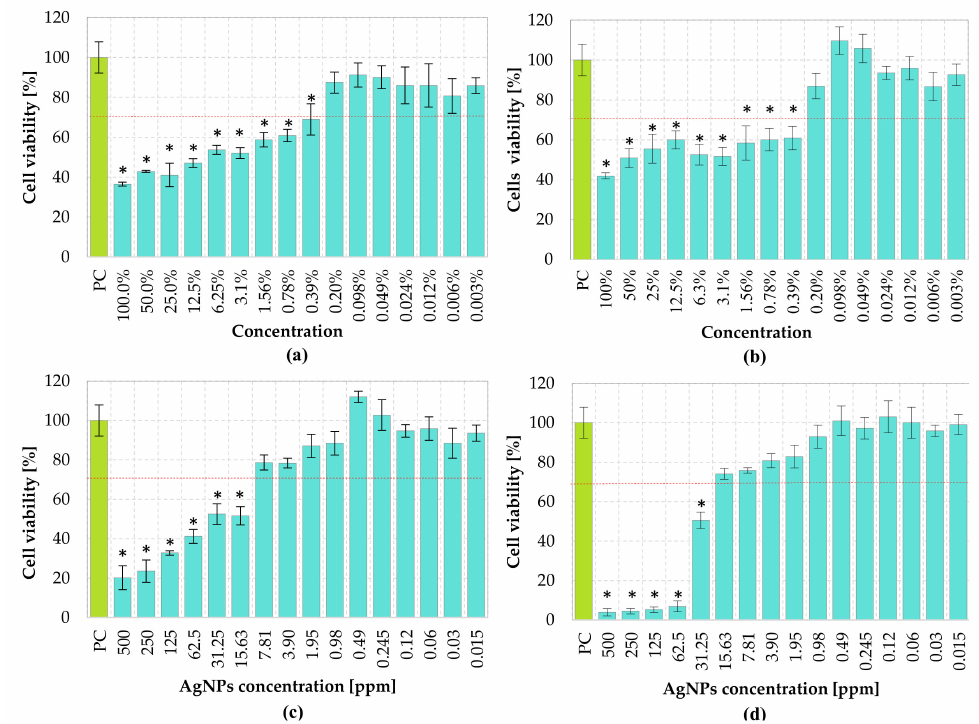
Figure 7. L929 fibroblasts viability (MTT assay) treated with the C. incanus extract ( a ), infusion ( b ), AgNPs prepared with extract ( c ), and AgNPs prepared with infusion ( d ). The values show cell viability calculated in comparison to cells cultured in medium (100% viability). Statistically significant ( p < 0.05) differences are marked with